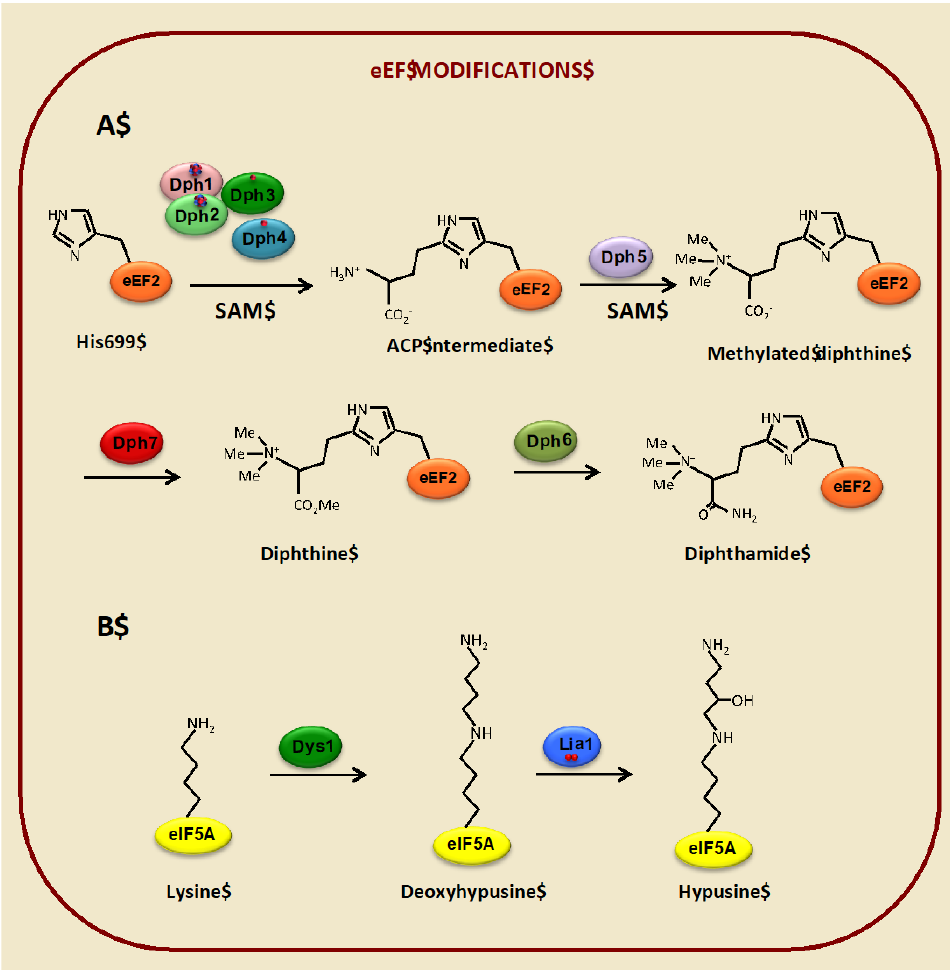
Figure 2. Iron-dependent proteins involved in the modification of the elongation factors eEF2 and eIF5A in the budding yeast S. cerevisiae . ( A ) Enzymatic steps in the diphthamide modification of eEF2. The ISCs in Dph1 and Dph2 are represented by red circles (iron nuclei) and blue circles (sulfur nuclei). Red circles in Dph3 and Dph4 represent mononuclear iron cofactors. Me means CH 3 . ( B ) Enzymatic steps in the hypusine modification of eIF5A. Red circles in Lia1 represent a binuclear iron cofactor.